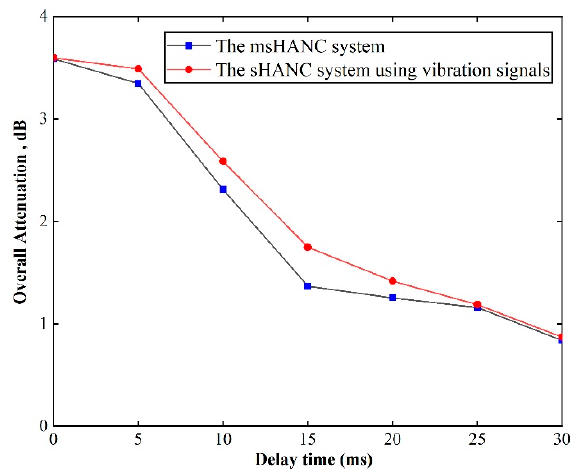
Figure 11. The predicted overall reduction performance of two control systems when different delays are added into reference signals.